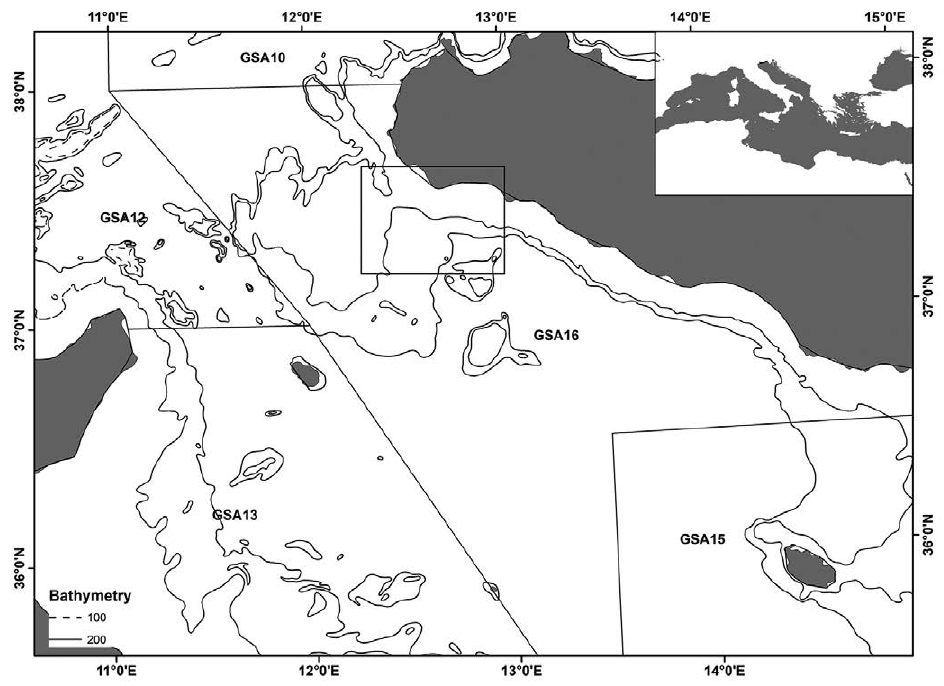
Fig. 1. – Map of the study area where fisheries data are collected for the assessment of deep-water rose shrimp and hake. The black square box indicates the area where the experimental survey was carried out in 2015.